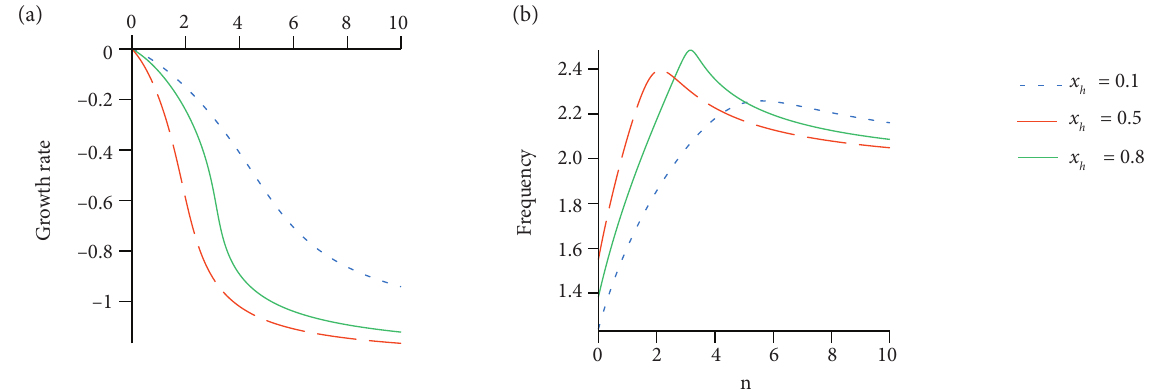
Figure 17. Thermoacoustic characteristics of a ducted resonator as resonator position varies (1L mode, τ = 0.6, x